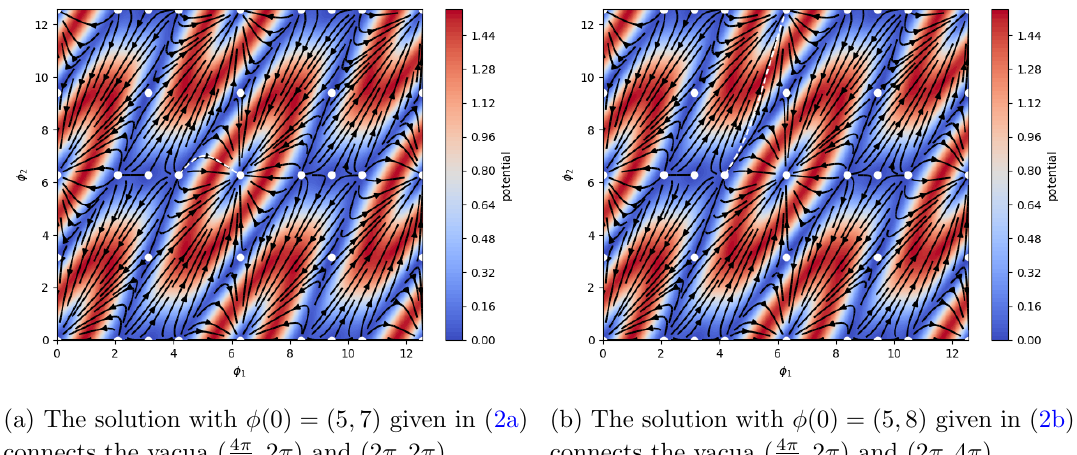
Figure 4. The r (cid:17) W lines are plotted as black arrows over the potential U . The paths described by the solutions in (cid:12)gure 2 are plotted as white dashed lines connecting the vacua which are the white